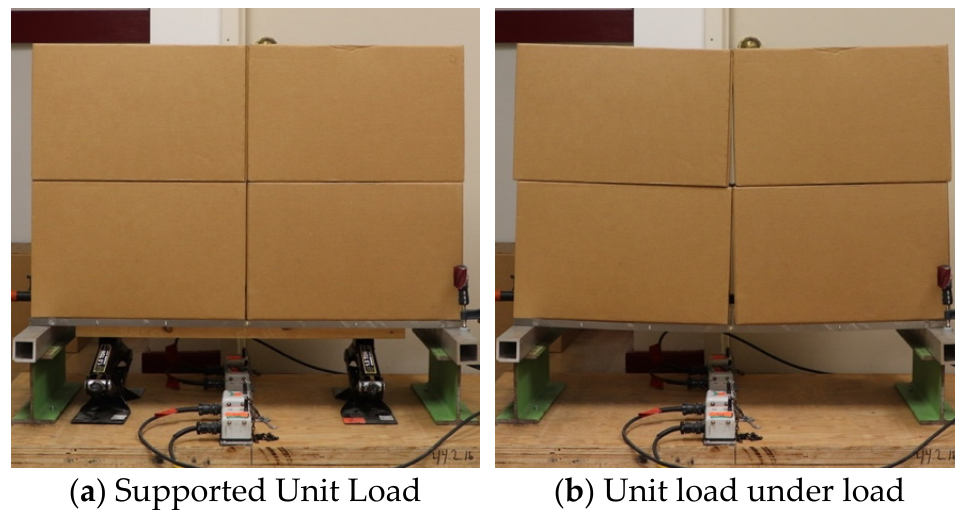
Figure 8. Picture of unit load segment with 2 layers of large boxes, fully supported ( a ) and showing deflection under load ( b ).